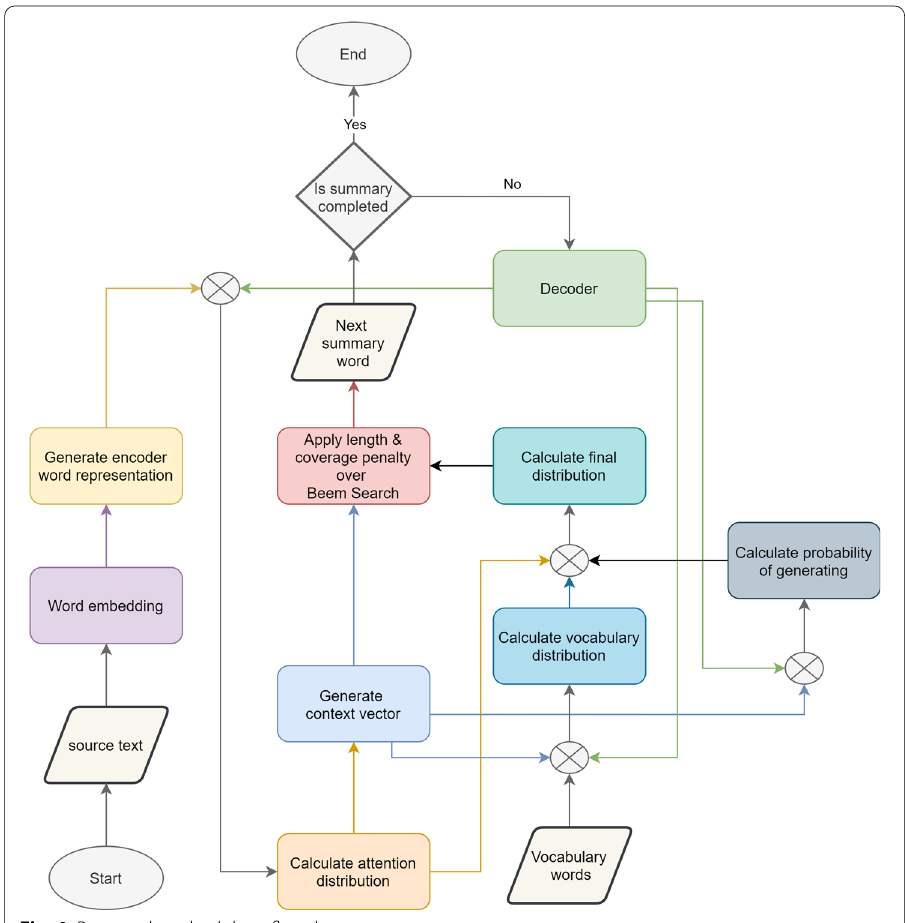
Fig. 4 Proposed methodology